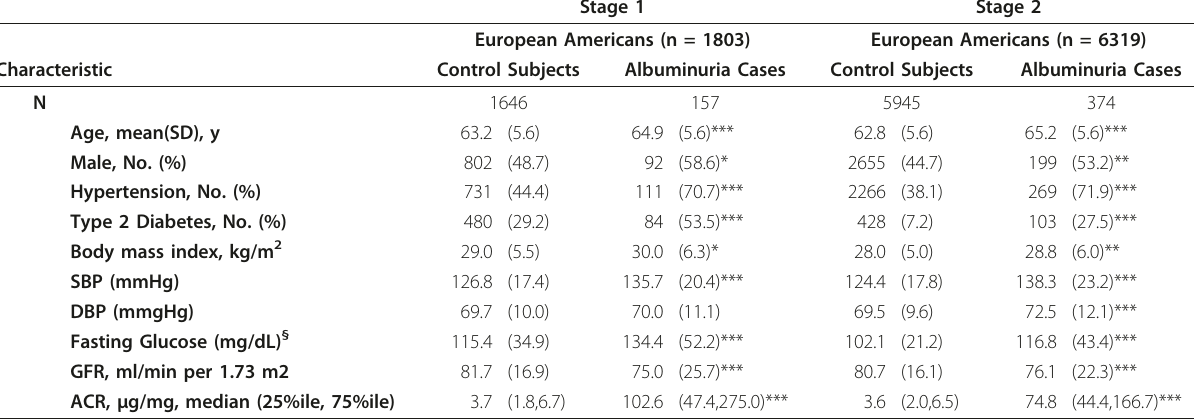
Table 1 Baseline Characteristics. Clinical characteristics of study subjects by Race and Albuminuric